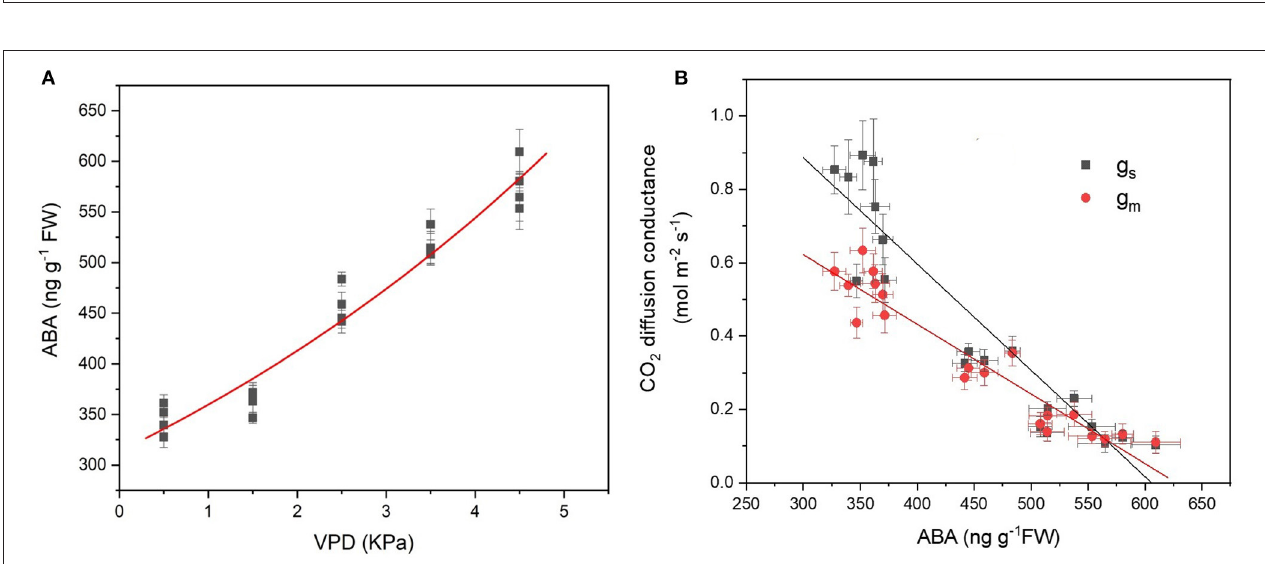
FIGURE 6 | Leaf ABA content in response to the VPD (A) and its correlation with the CO 2 diffusion conductance of g s and g m (B) . The regression lines shown are ABA = 301.3e 0.15VPD , R 2 = 0.96, P < 0.01; g s = − 0.0029 ABA + 1.76, R 2 = 0.85, P < 0.01; g m = − 0.0019 ABA + 1.19, R 2 = 0.88, P < 0.01.